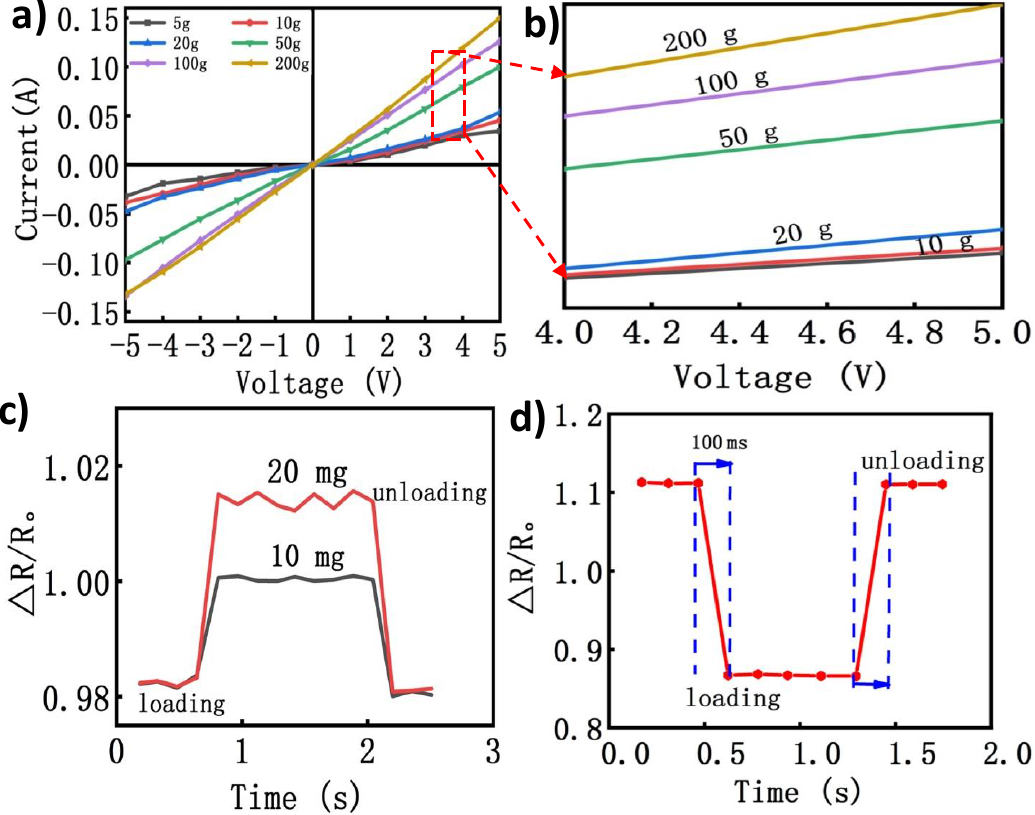
Figure 4. ( a ) Current–voltage curves (I-V) of the 3D porous conductive composite over the range from −5 to 5 V under different strains; ( b ) a magnified view of ( a ); ( c ) detection the response to micro-pressure of 10 mg and 20 mg; ( d ) real-response time of the 3D porous piezoresistive tactile sensor, with an applied pressure of 5 Pa under a loading and unloading process.